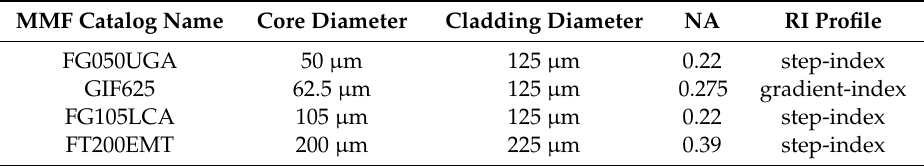
Table 3. Main technical parameters of selected MMFs used in the experiments.